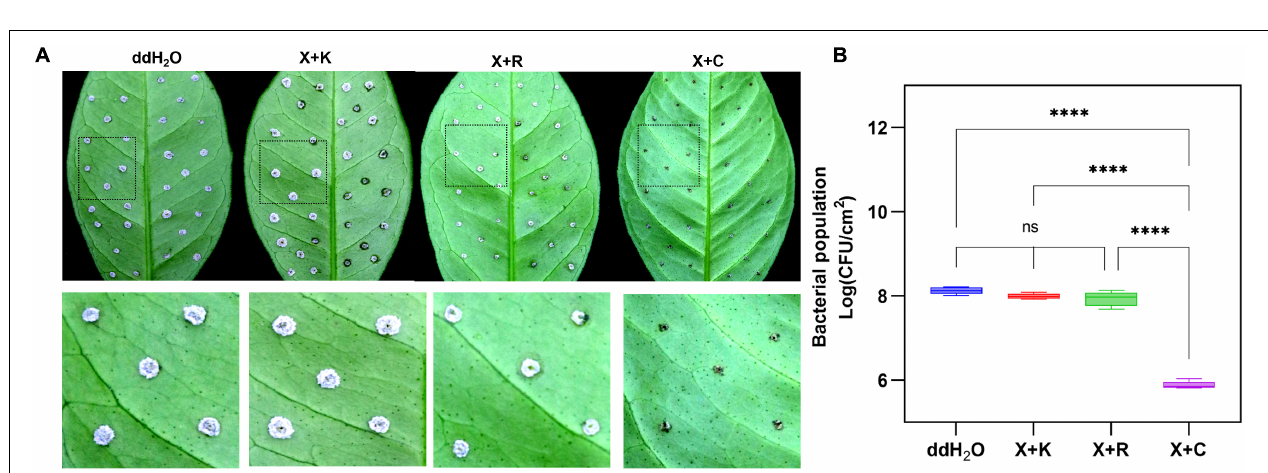
FIGURE 5 | Indoor prevention effect of different mixture combinations of bactericides. (A) After 7 days, CBC development on citrus leaves was pretreated with three different 1:1 synergistic bactericides using the pinprick-inoculation method. The experiments were repeated three times with similar results. (B) The result represents the bacterial population among the different treatments using the fluorescence spot counting method at 7 days postinoculation. The bar value shown is the mean of three independent experiments. The vertical bars represent the SD of the means. Statistical analysis was studied by one-way ANOVA following multiple comparisons with the Tukey’s test (95% CI) using GraphPad Prism 9 ( ∗∗∗∗ p < 0.0001, nsP >0.05). X + C:1:1 mixture formulation of 1.2% xinjunan acetate (AS) and 30% copper oxychloride (SC); X + R:1:1 mixture formulation of 1.2% xinjunan acetate (AS), and 20% resin acid copper (EW). X + K: 1:1 mixture formulation of 1.2% xinjunan acetate (AS) and 33% kasugamycin xine-copper (SC); ddH 2 O: double-distilled water.